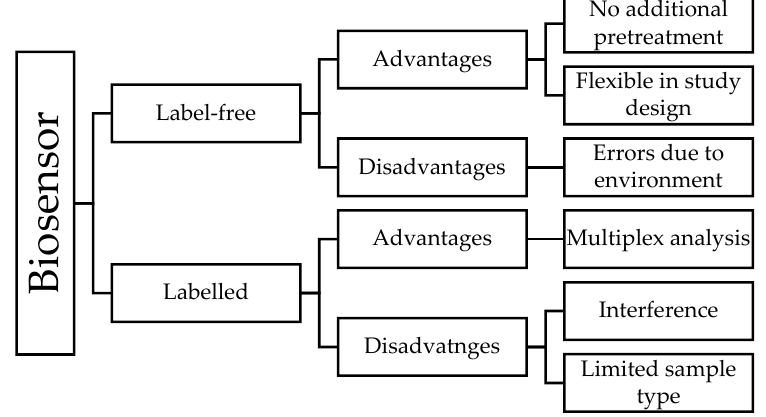
Figure 3. Biosensor categories, advantages and disadvantages [122–124].